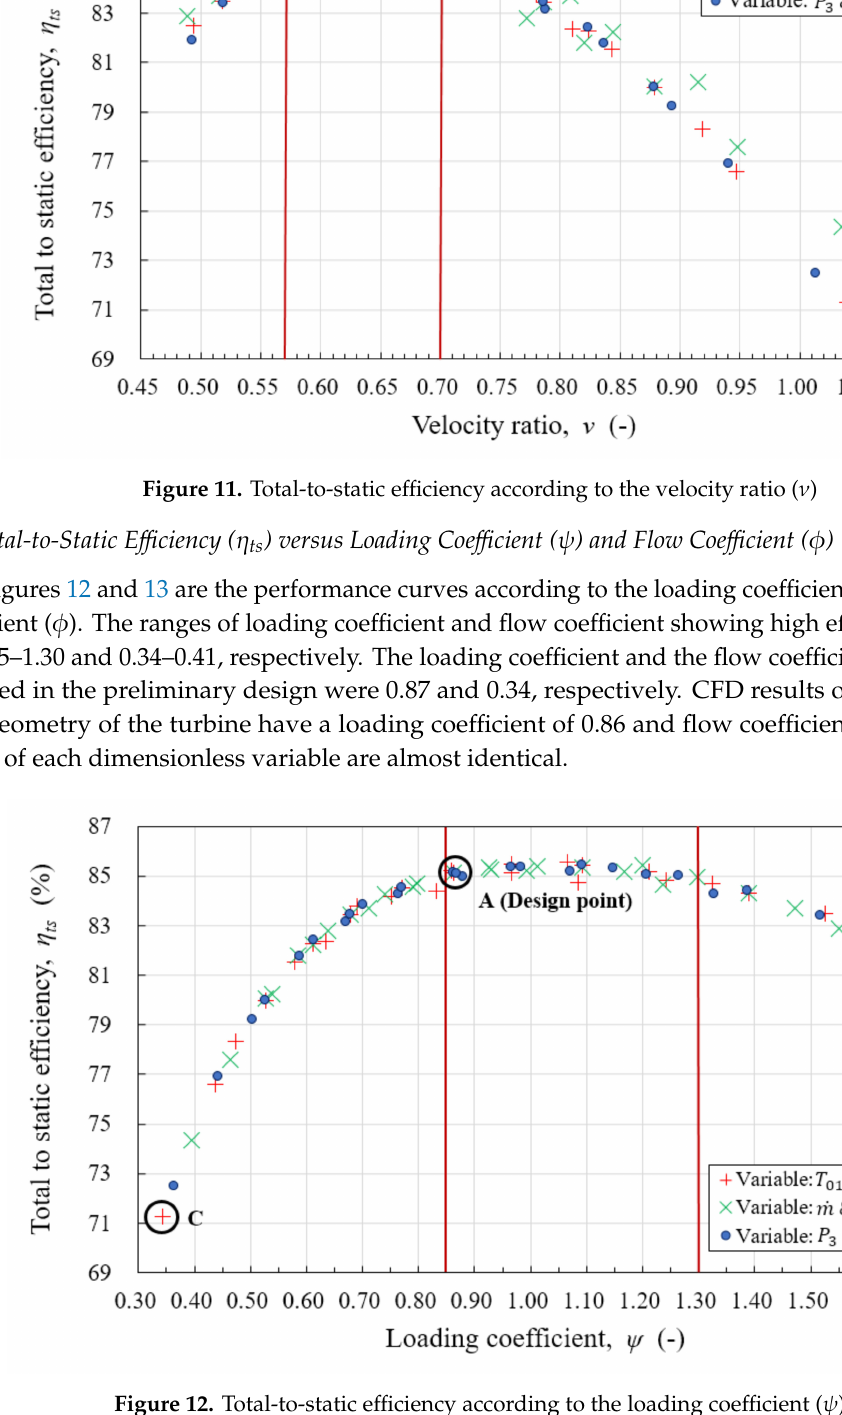
Figure 12. Total-to-static e ffi ciency according to the loading coe ffi cient ( ψ